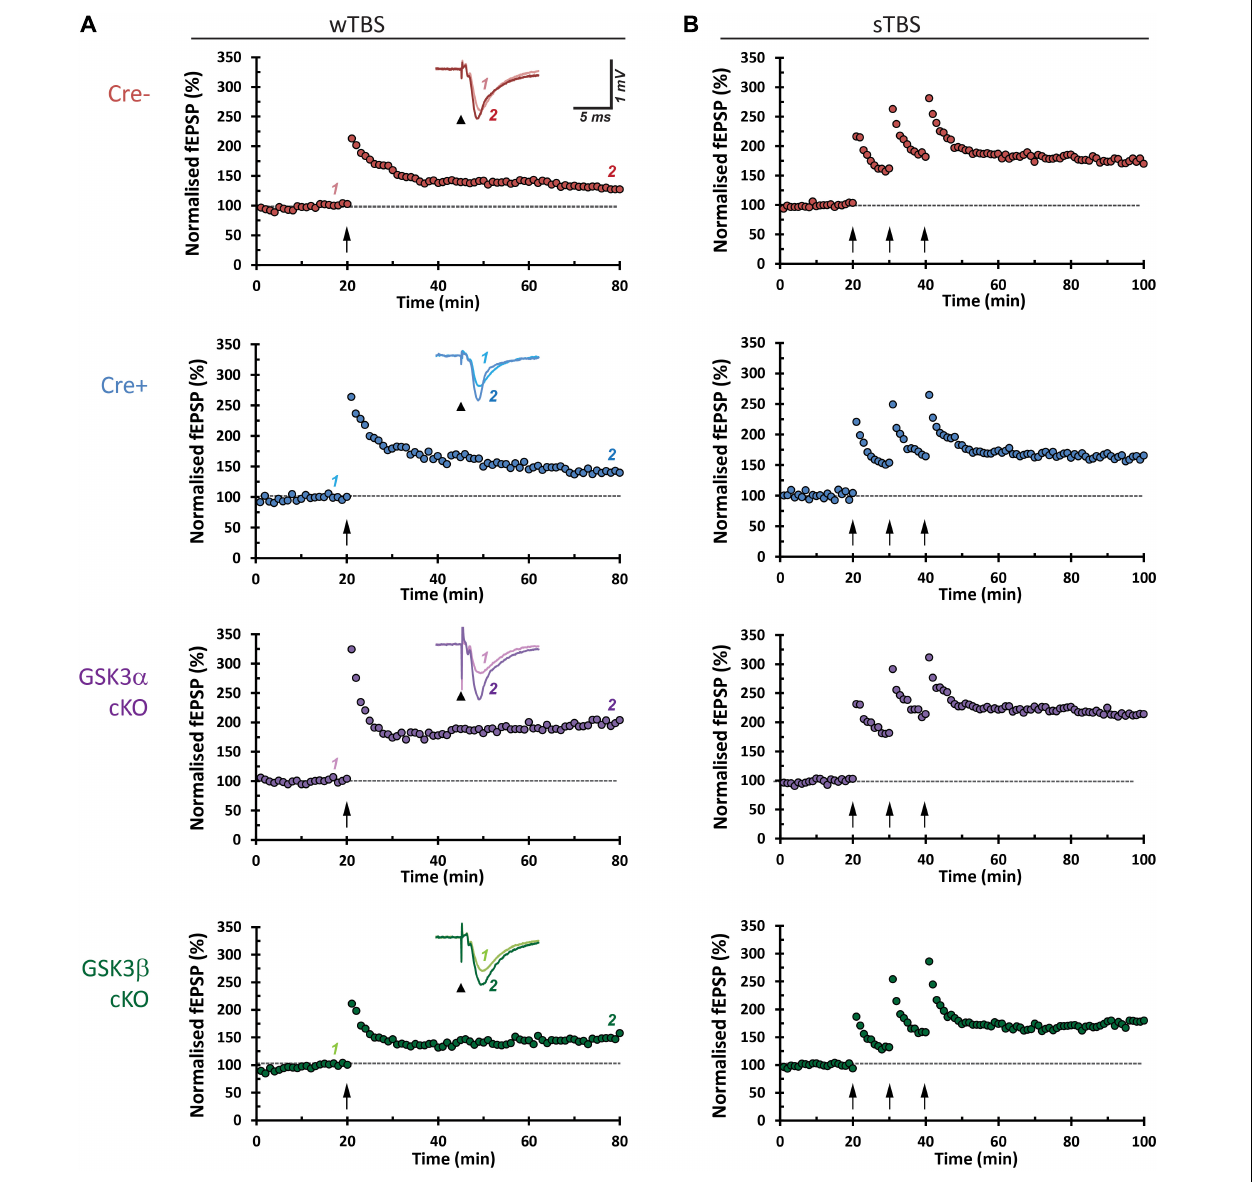
FIGURE 4 | Representative hippocampal slice LTP time-course plots. Each row shows an experimental LTP result from a Cre-, Cre+, GSK3 α cKO, and GSK3 β cKO hippocampal slice. (A) The left column panels are from LTP experiments on samples that received a 25-pulse, weak, theta-burst stimulation (wTBS) induction protocol (arrow, time = 20 min). Insets show averaged synaptic response (5 traces) obtained by the first of paired pulses of current stimulation (arrowhead, stimulus pulse and corresponding artifact), before (1) and after LTP (2), superimposed. (B) Sample results from experiments that received the sTBS (3 × TBS) induction